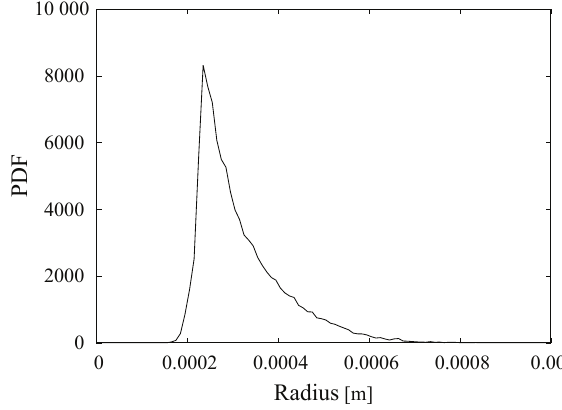
Figure 6. PDF of the sizes of the surface raindrops when they reach 600m in height (nearly cloud bottom). Raindrops smaller than 200µm in radius evaporated completely in the unsaturated air below the cloud bottom before reaching the ground surface and thus could not become surface